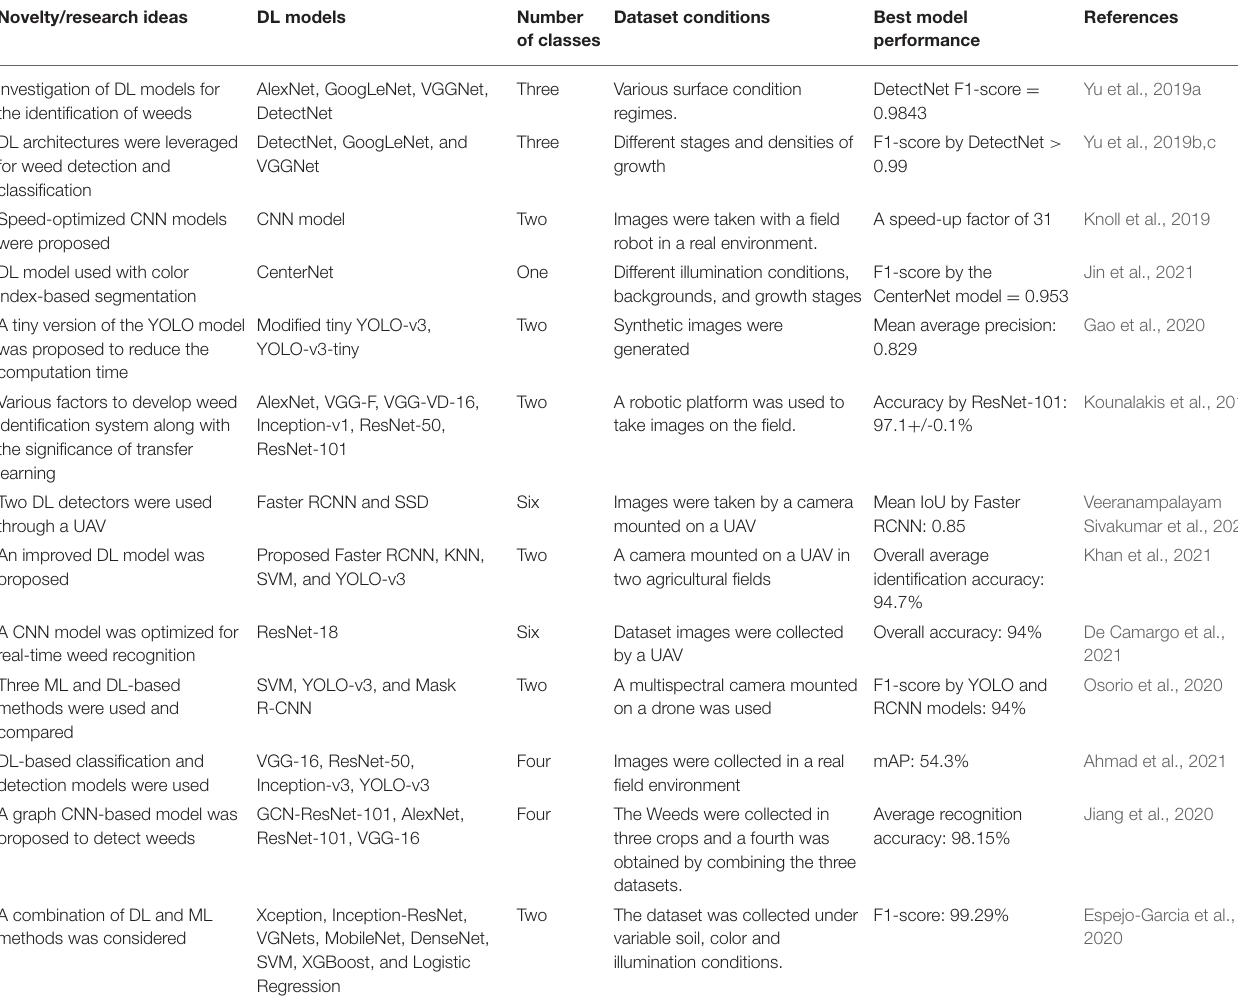
TABLE 1 | Summary of research articles related to weed detection by deep learning (DL) (divided in terms of novelty and research ideas of the